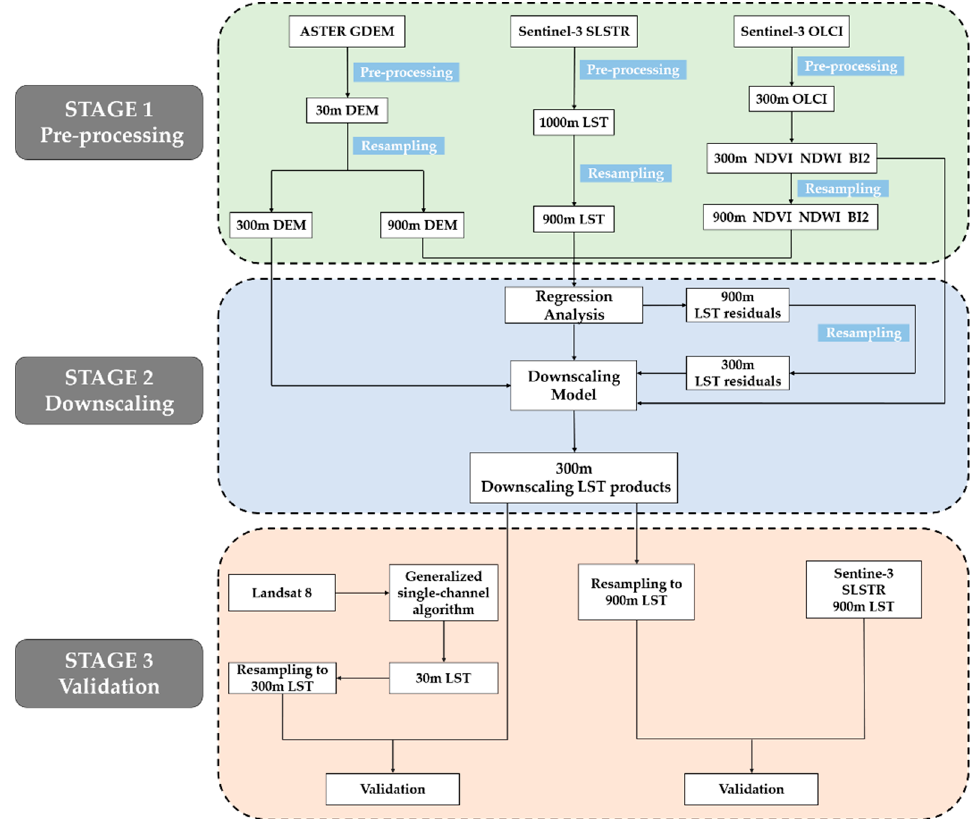
Figure 2. Data processing flow chart.